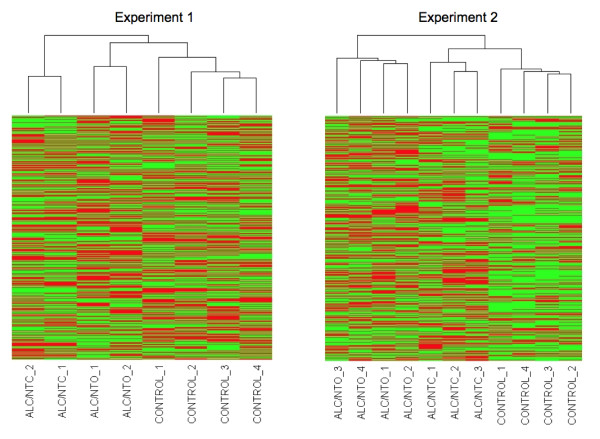
Hierarchical clustering by arrays in Experiment 1 and Experiment 2.